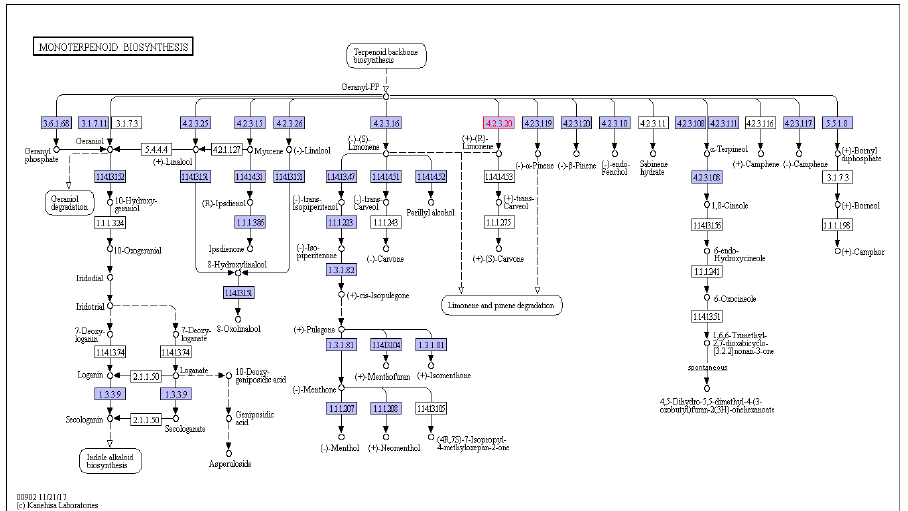
Figure 6. A. marmelos leaf transcriptome encoded enzymes (highlighted) involved in the monoterpenoid biosynthetic pathway identified in the leaf. Forests 2018 , 9 , x FOR PEER REVIEW